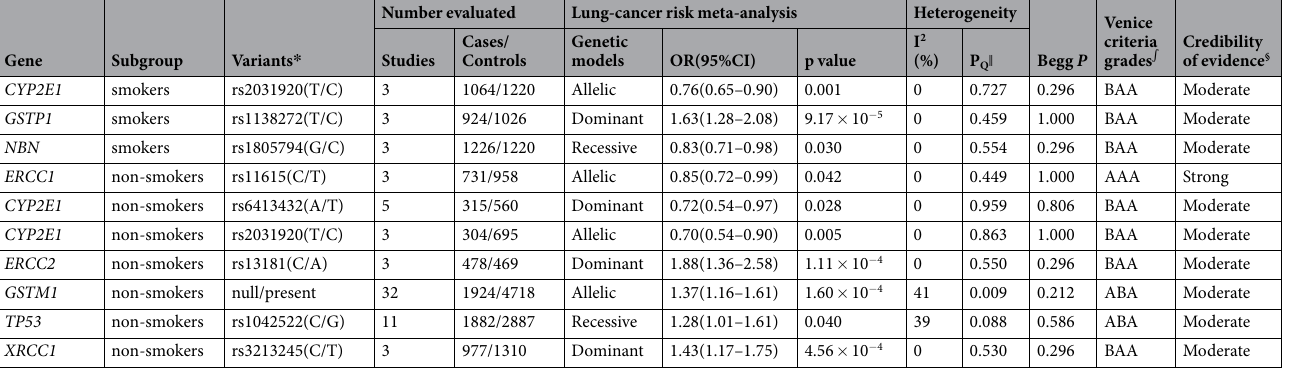
Table 3. Genetic variants with significant associations with lung cancer risk in subgroup meta-analyses with strong or moderate cumulative evidence (Continued on next page). OR = odds ratio; 95%CI =